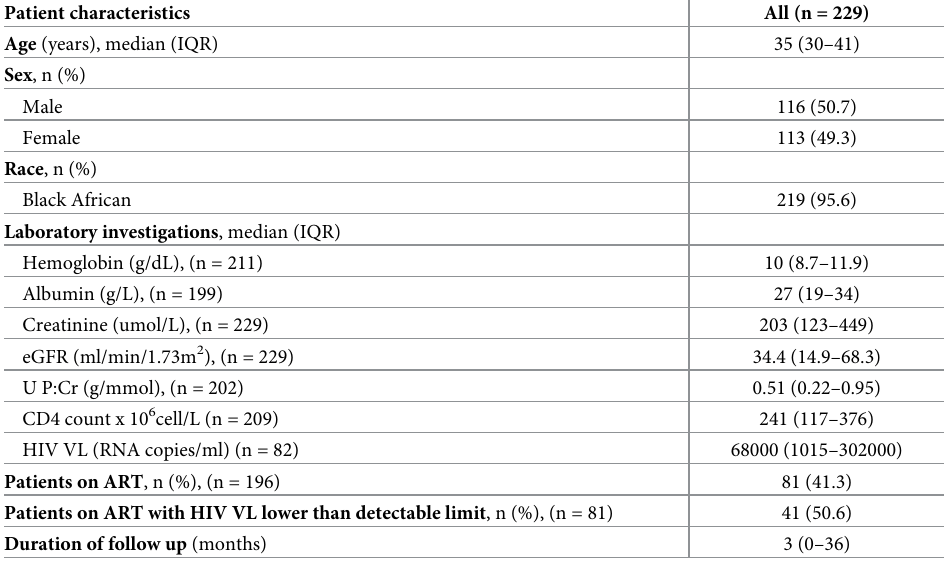
Table 4. Baseline characteristics in 229 HIV positive patients with serial kidney function